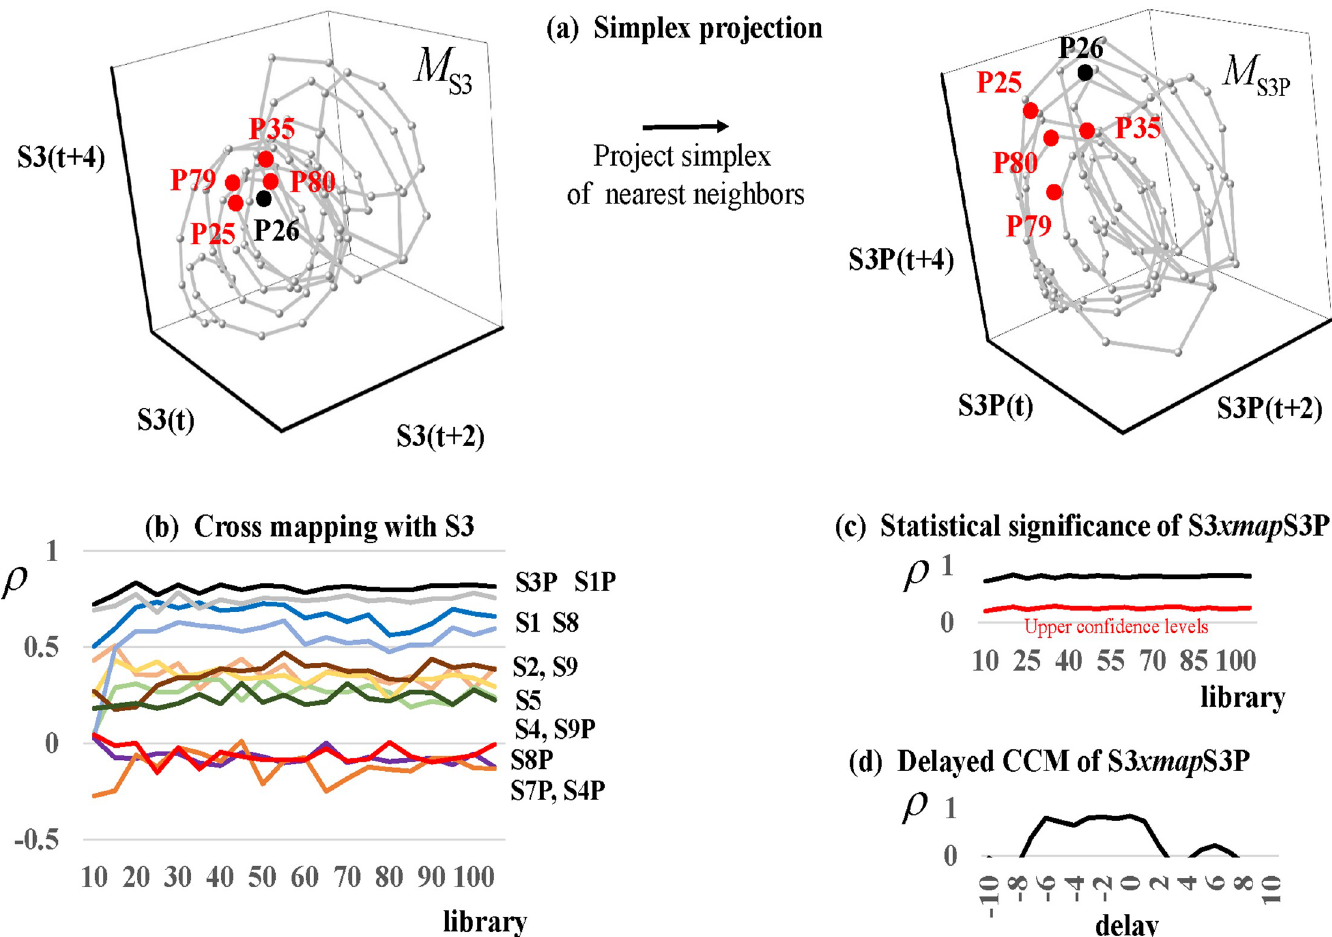
Fig 6. Convergent cross mapping. (a) Convergent Cross Mapping (CCM) operates with a ‘simplex-projection’ algorithm [15]. We illustrate this with the cross mapping S3 xmap S3P. We reconstruct the attractors M S3 and M S3P using S3 and S3P and two of their forward-delayed copies as phase-space coordinates, respectively, and fix a single reference point (P26) on M S3 at week 26 (left plot). We next identify the reference point’s m +1 nearest neighboring points, where m = 3 is the embedding dimension of M S3 . These neighboring points (P80, P79, P35, and P25) form a simplex around the reference point on M S3 that is projected onto M S3P by transferring the time coordinates of the reference point and nearest neighbors from M S3 to M S3P (right plot). If there is a 1–1 mapping from M S3 to M S3P , then these points will be nearest neighbors on M S3P as well, and their weighted average will skillfully predict the corresponding reference point on M S3P (P26). This is repeated for a sampling of reference points on the M S3 . Cross prediction skill is measure with the correlation coefficient between reference points on M S3P and their predicted values; (b) Predictive skill should converge as the number of points used to construct M S3 (the ‘library’) increases. The figure shows the skill with which M S3 cross predicts other variables in the dataset. Convergent correlation coefficients closer to one reflect stronger causal interactions; (c) Statistically significant cross mappings must rest above upper 95% confidence bounds constructed with surrogate data; and (d) To distinguish causal interaction from synchronized behavior, cross mappings run at backward and forward delays must perform best at nonpositive delays as in the